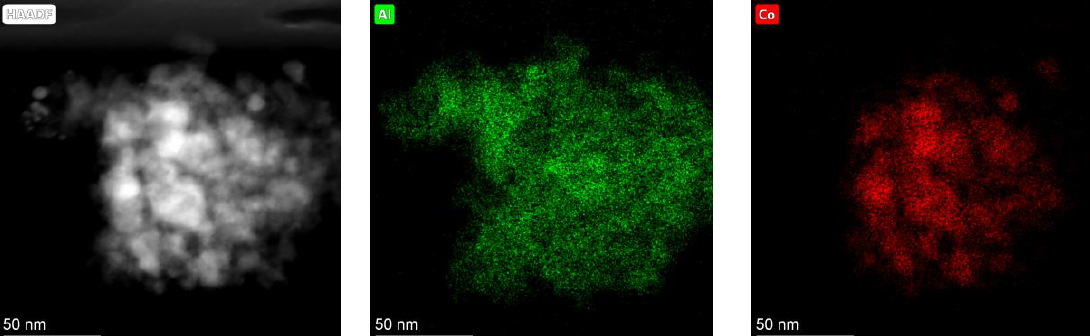
Figure 3. HAADF-STEM image of sample 25%Co. Elemental mapping legend: (green) aluminum and (red) cobalt.